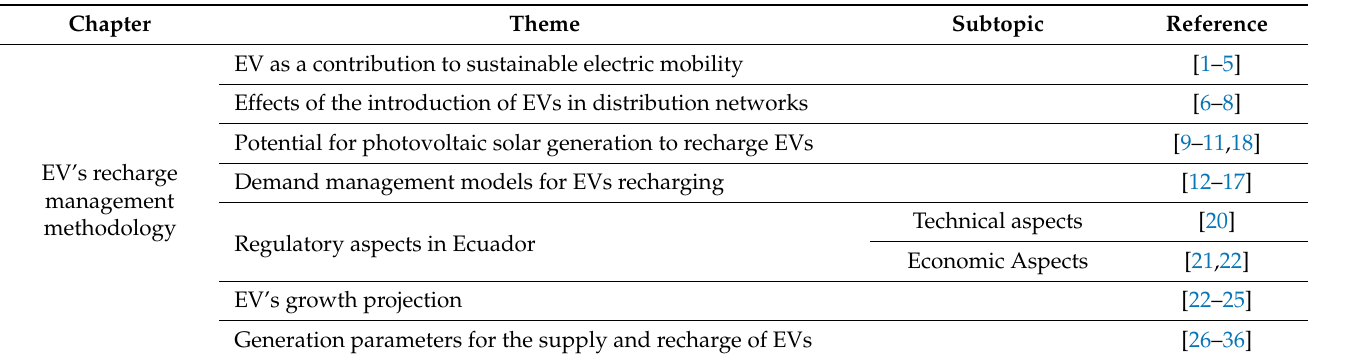
Table 1. Literature review of the methods used for the